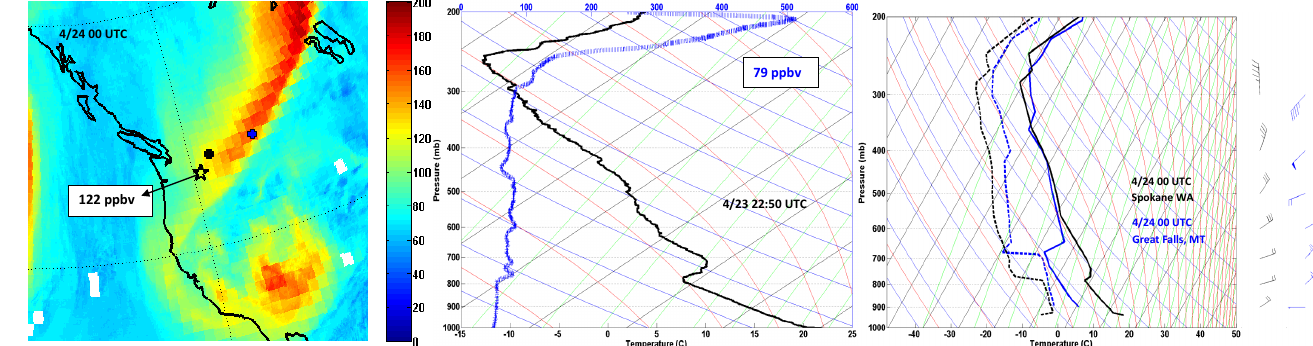
Fig. 6. (a) The zoomed MUTOP image from 24 April at 00:00UTC shows the location of the Richland, Washington sonde launch site (black star) relative to the dry-air streamer ozone enhancement in the UT. The color bar represents layer-average UT ozone VMR inppbv. The black and blue crosses show the location of the Spokane, Washington and Great Falls, Montana radiosonde sites. (b) Skew-T plot of the Richland ozonesonde from 22:50UTC, 23 April 2006, launched 70min before the preceding MUTOP image. Note the dewpoint sensor was not reporting for this sonde, and there were no winds available, but the UT layer average ozone was 79ppbv. (c) Two additional Skew-T plots show radiosonde profiles of temperature, dewpoint temperature and column wind for Spokane, WA (solid black, black dash, and black wind barbs),and Great Falls, MT (solid blue, blue dash and blue wind barb) for 24 April at 00:00UTC, on either side of the UT dry-air streamer feature. Note the dramatic change in UT wind direction between these two